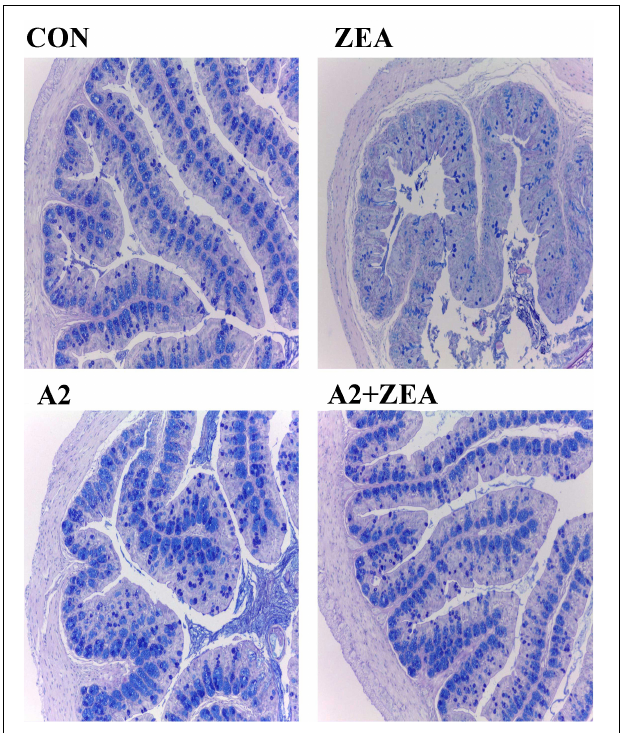
FIGURE 3 | Results of Alcian blue